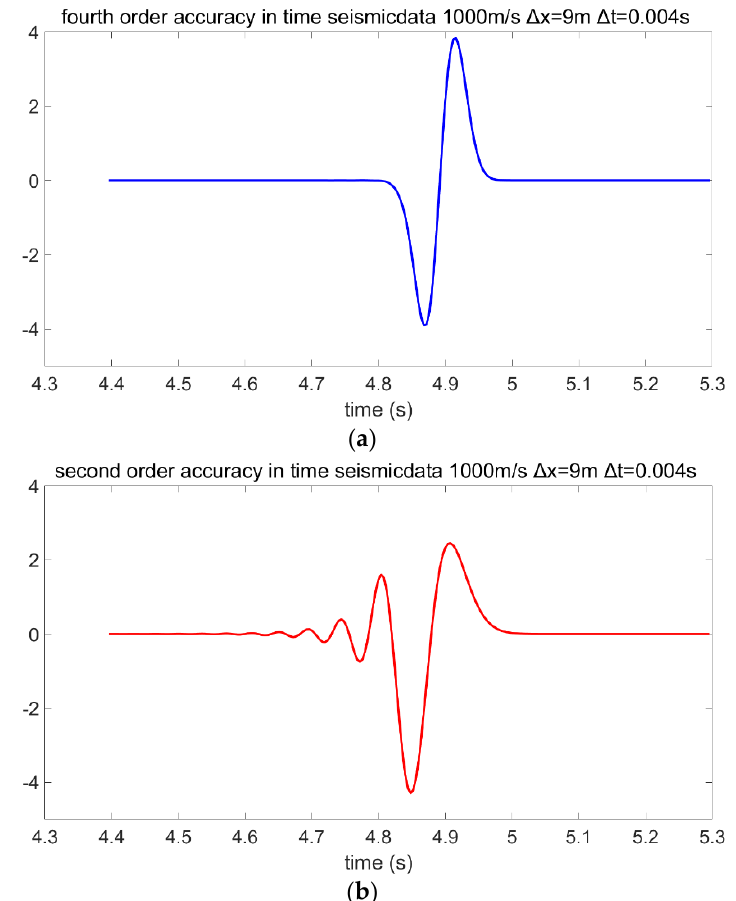
Figure 7. ( a ) CCD is used to simulate the numerical simulation of seismic records in the 1D homogeneous medium model with fourth-order accuracy in time, dt = 0.004 s; ( b ) CCD is used to simulate the numerical simulation of seismic records in the 1D homogeneous medium model with second-order accuracy in time, dt = 0.004 s.